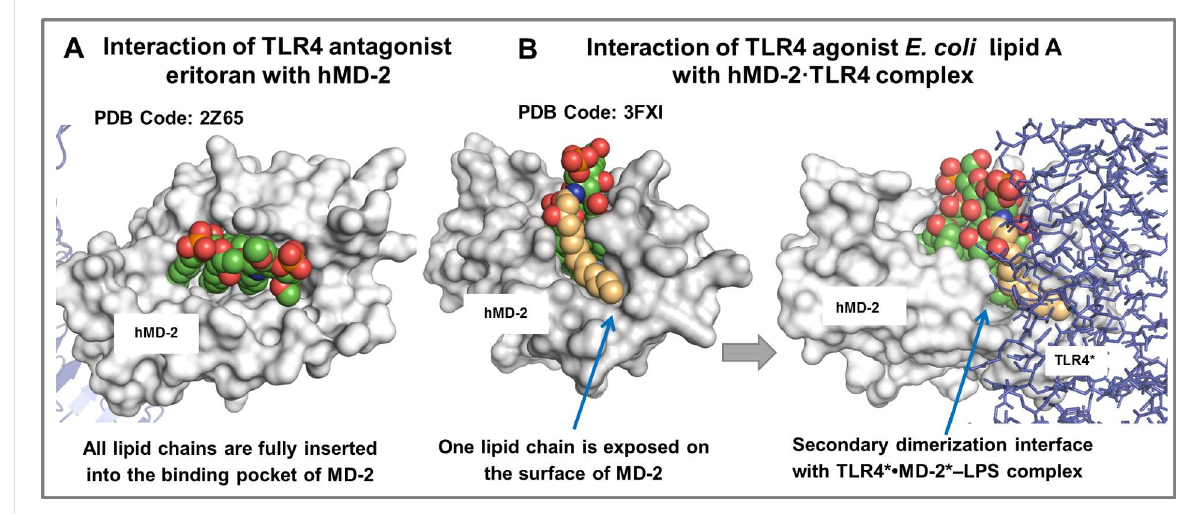
Figure 4: Co-crystal structures of (A) hybrid TLR4·hMD-2 with the bound antagonist eritoran (PDB: 2Z65, TLR4 is not shown); (B) homodimeric E. coli Ra -LPS·hMD-2 ∙ TLR4 complex (PDB code: 3FXI, TLR4 is not shown, only lipid A portion is shown for clarity). Images were generated with PyMol.